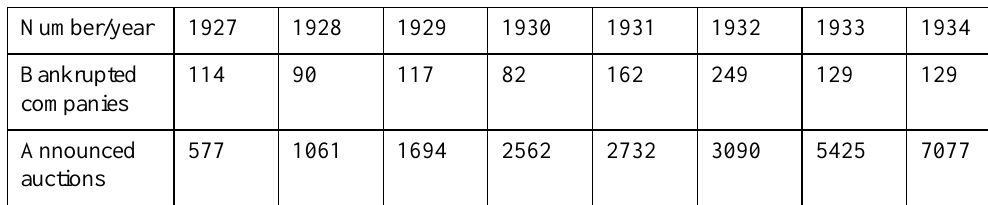
Table 8. Bankrupted companies and announced auctions in Latvia (1927‒1934) (Karnups, 2012, p.